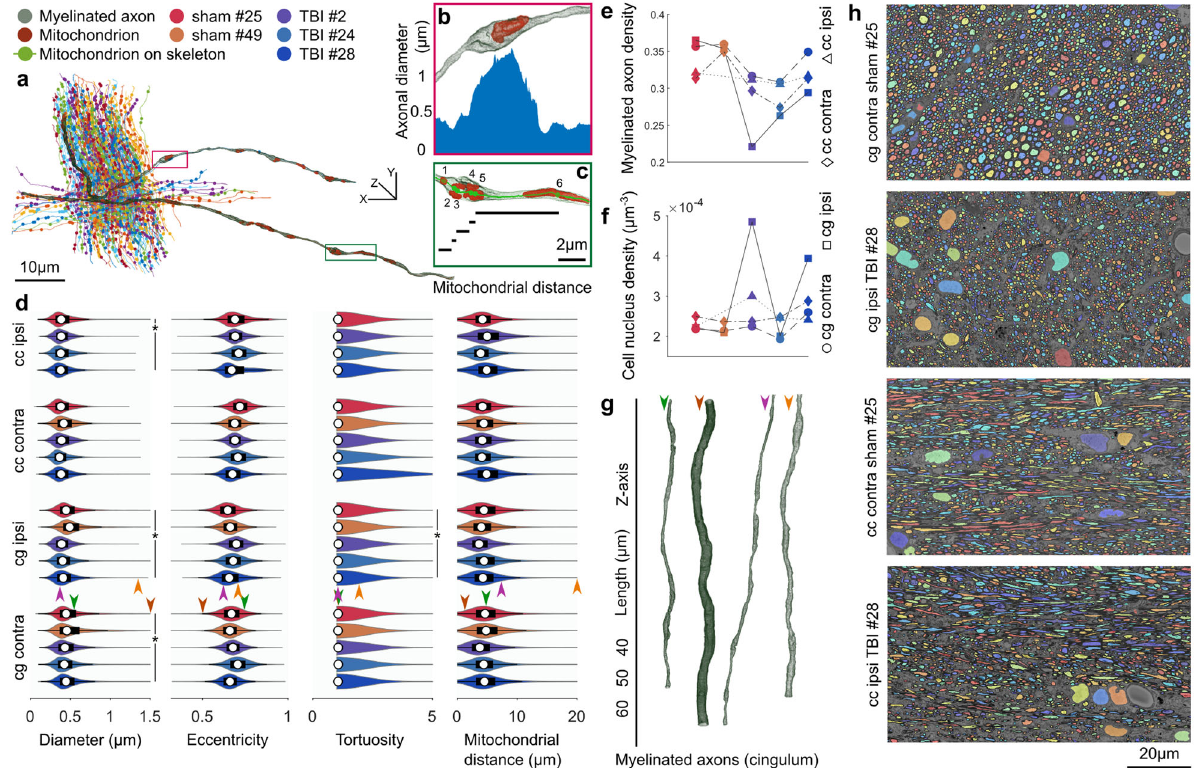
Fig. 5 White matter morphology analysis. a A bundle of myelinated axons was sampled from the cingulum of the sham # 25 dataset. Myelinated axons are represented by their curve skeletons. The centroids of mitochondria were projected on the axonal skeletons, shown as fi lled-circles. b A small section of a myelinated axon from a represents how the axonal diameter can vary substantially along its length. The increased axonal diameter can be related to the accumulation of mitochondria. The plot shows the axonal diameter along the magni fi ed section of the myelinated axon. c A small section of a myelinated axon from a shows the measure of inter-mitochondrial distance. Five mitochondria are accumulated with distances less than 1 μ m, and one mitochondrion is distant from others with over 5 μ m distance. d DeepACSON quanti fi ed the axonal diameter, eccentricity, and tortuosity of about 288 000 myelinated axons and the inter-mitochondrial distance of about 1 800 000 mitochondria. On each bean plot, the central mark indicates the median, and the left and right edges of the box indicate the 25 th and 75 th percentiles, respectively. The whiskers extend to the most extreme data points not considered outliers. The colors correspond with the animal ID. e The comparison of the density of myelinated axons, as the ratio of the volume of myelinated axons to the myelin volume plus the volume of myelinated axons. The color of the indicators corresponds with the animal ID. f The comparison of the density of cells, as the number of cell nuclei over the dataset volume. The color of the indicators corresponds with the animal ID. DeepACSON segmented about 2 600 cell nuclei in the ten large fi eld-of-view datasets. g 3D rendering of myelinated axons from the cingulum visualizes the normative and outliers of the axonal diameter distribution. Each myelinated axon is given an arrowhead to mark its measurements in panel d . h Representative images of the cingulum and corpus callosum in sham-operated and TBI rats visualize the smaller density of myelinated axons caused by the